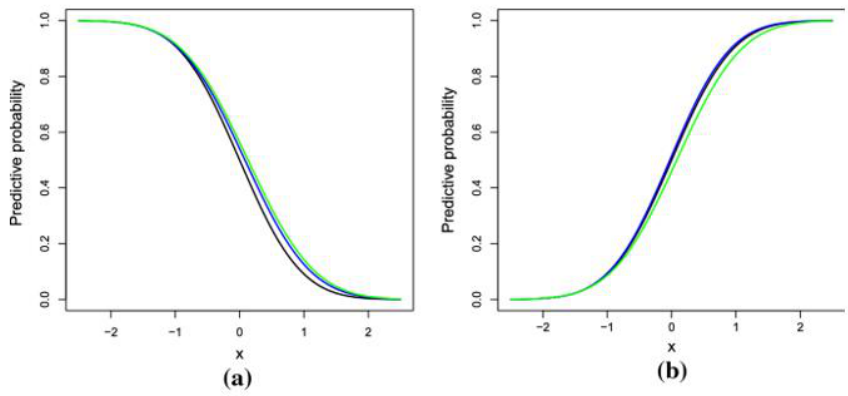
Figure 2. Visualization of the Copula-based link function in bivariate regression.